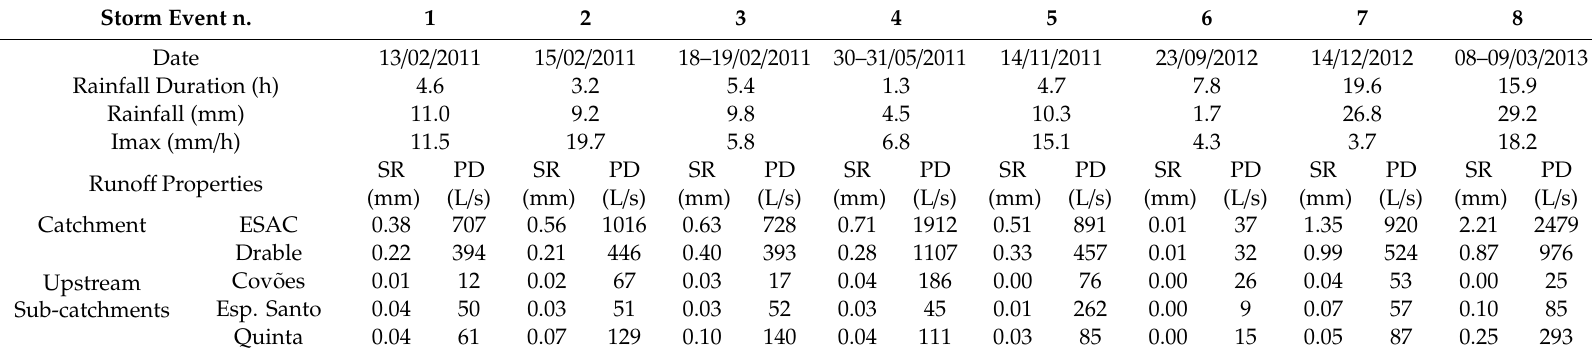
Table 1. Hydrological properties of the storm events used for HEC model calibration (n. 1, 4, 5, 6 and 7) and validation (n. 2, 3 and 8), including rainfall duration, depth and maximum intensity over a 15-min period (Imax), and surface runo ff depth (SR) and peak discharge (PD) in the five stream gauging stations. Storm Event